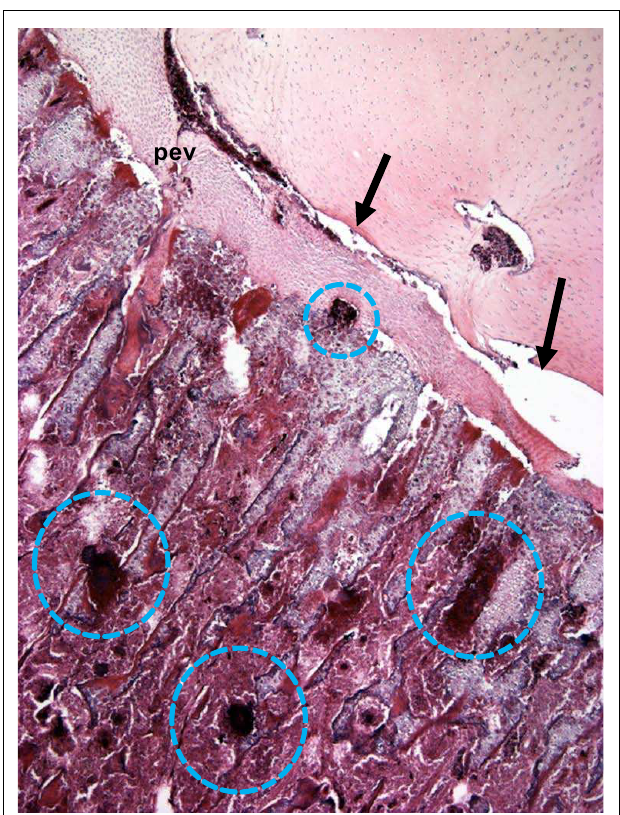
FIGURE 6 | Microphotograph of the proximal femoral head of a 38-day-old broiler with definitive femoral head necrosis (hematoxylin and eosin stain; 5 µ m section). Bacterial foci are circled. Arrows indicate an infected osteochondrotic cleft at the interface between the epiphyseal cartilage and the physeal cartilage. A degenerating penetrating epiphyseal vessel (pev) is associated with the